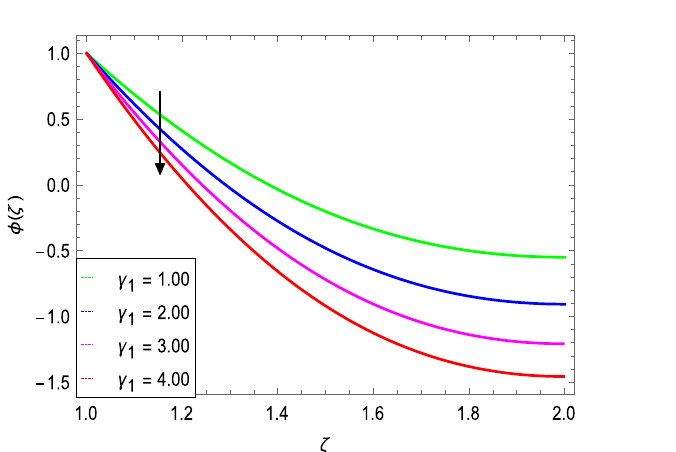
(ζ) as a function of E . ϕ